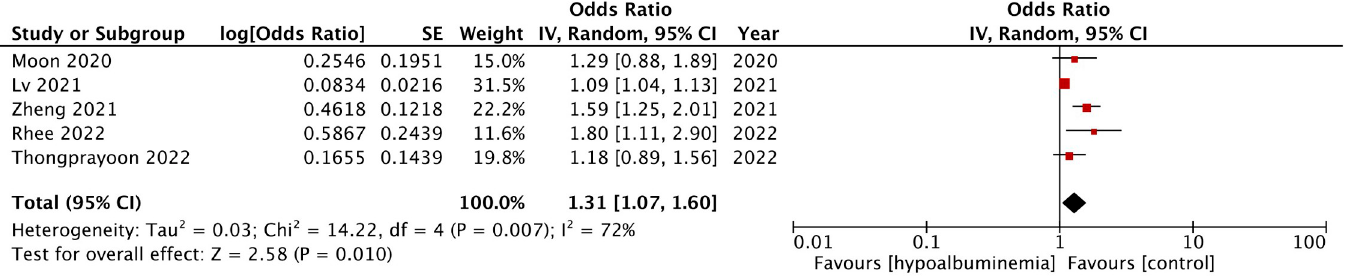
Fig 2. Meta-analysis of the association between hypoalbuminemia and mortality after CRRT.